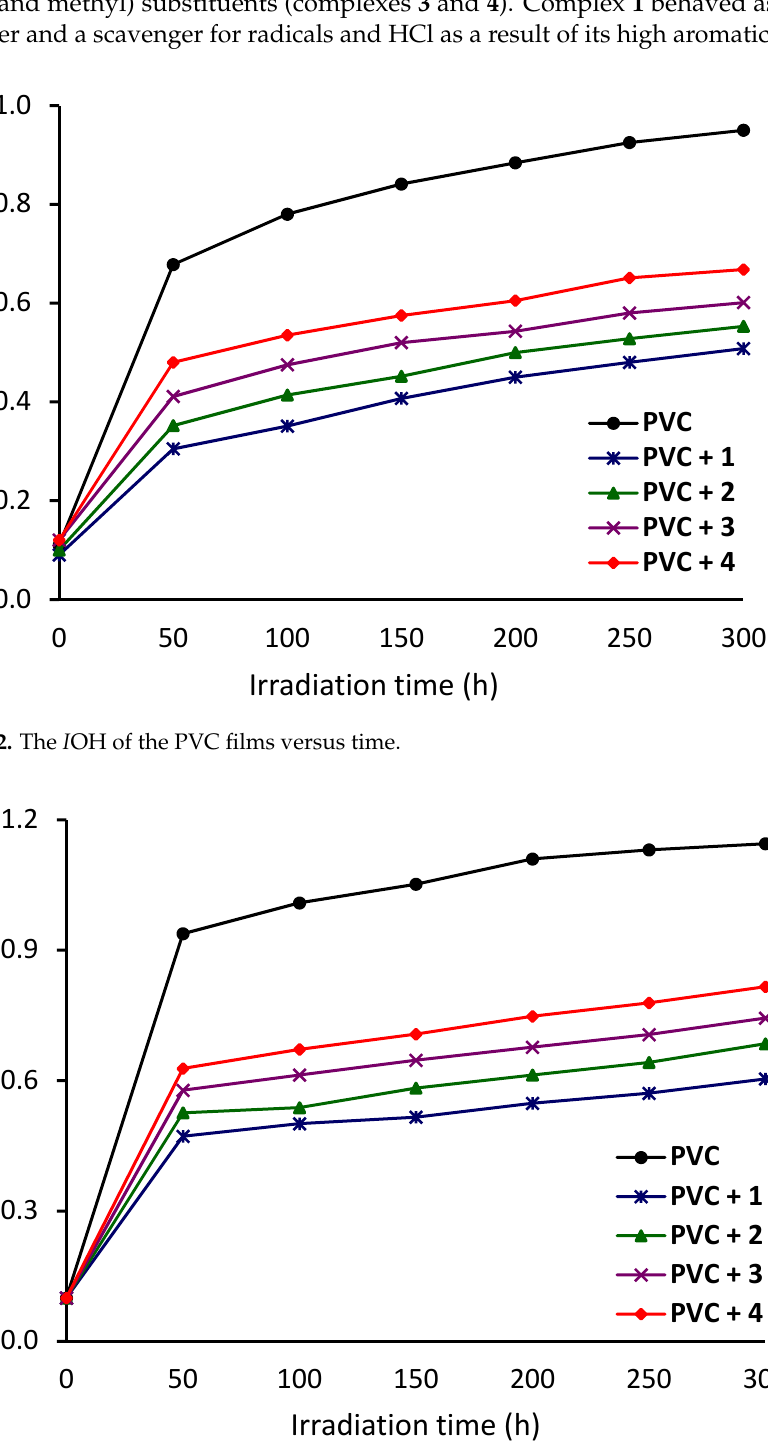
Figure 4. The I C=C of the PVC films versus time. 3.3. Investigation of PVC Photodegradation Using Weight Loss The PVC irradiation led to the elimination of volatiles, such as HCl gas, and a de- crease in the polymer weight [57]. The polymeric material weight loss can be used as a tool for assessing the level of damage that the irradiation caused. Thus, the PVC films were weighed ( W 1 ) and irradiated followed by a measurement of weight after every 50 h ( W 2 ). The weight loss (%) was calculated using Equation (2). The results are presented in